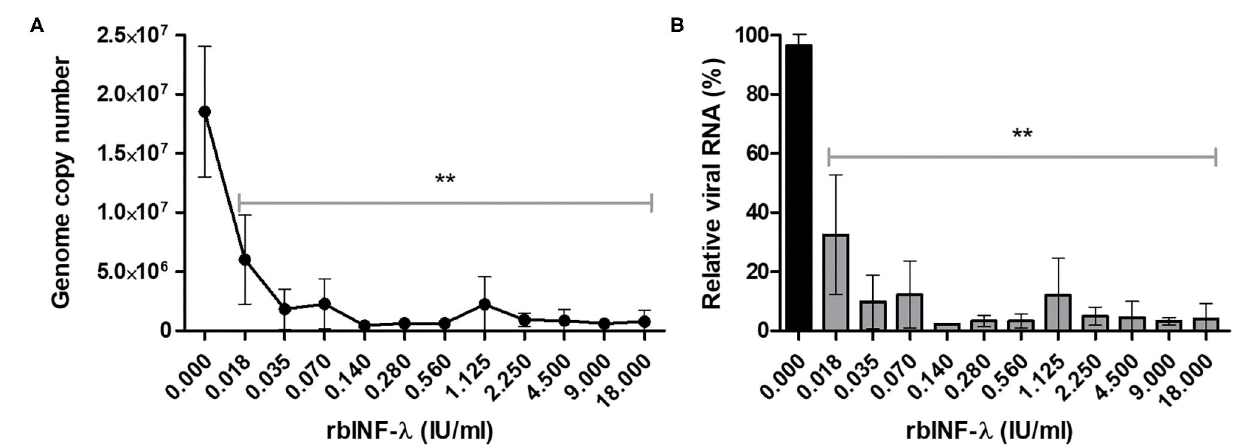
FIGURE 4 | Detection of SARS-CoV-2 genome. VERO cells were infected with serial dilutions of bovine rIFN- λ and SARS-CoV-2 RNA from culture supernatant samples and were quantified by qRT-PCR. Results are expressed as viral RNA copy number per milliliter (A) and percentage of relative viral RNA from mock-treated and infected cells (B) . Mean values ± SD from quadruplicate samples are depicted for each rbIFN- λ dilution. **Values significantly lower than those measured in the mock-treated and infected cells ( p <